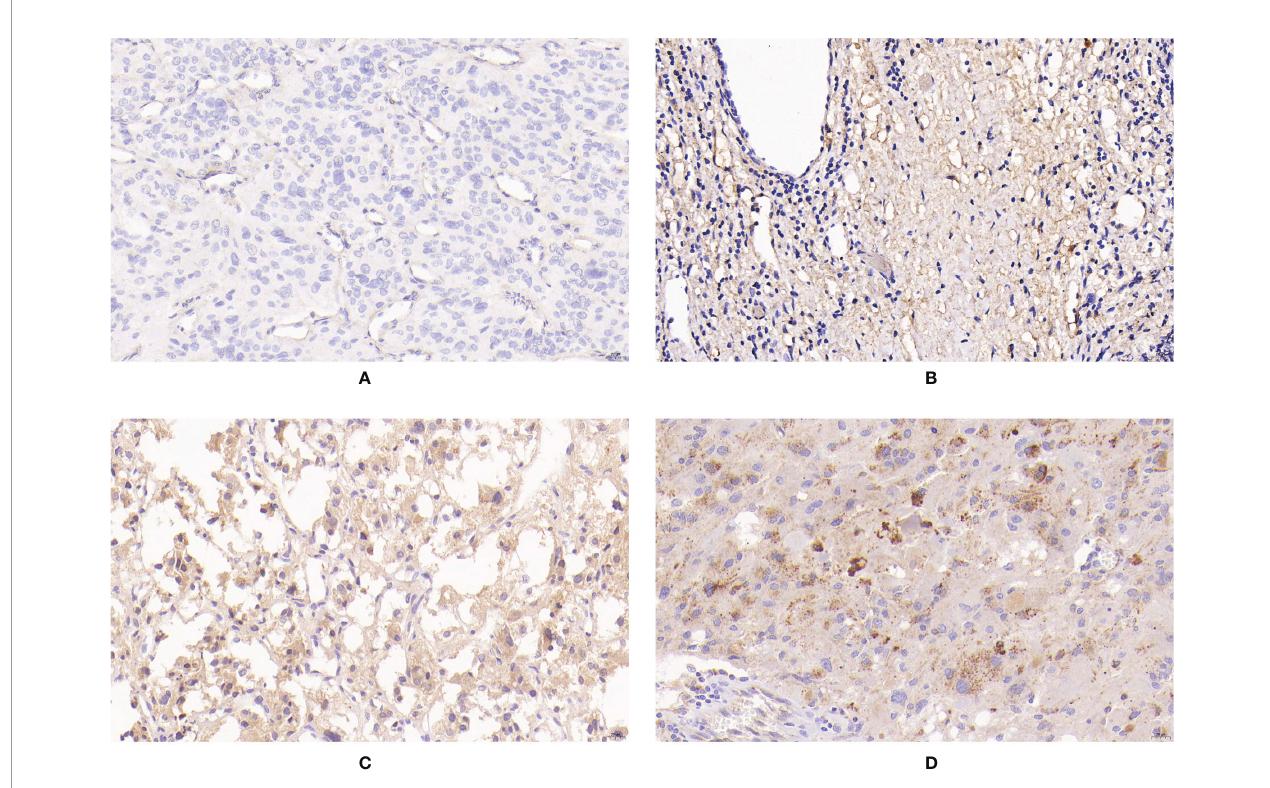
FIGURE 3 | Expression of apelin in PPGLs. (A) Negative immunostaining of apelin in PPGLs. (B) Weakly positive immunostaining of apelin in PPGLs. (C) Intermediately positive immunostaining of apelin in PPGLs. (D) Strongly positive immunostaining of apelin in